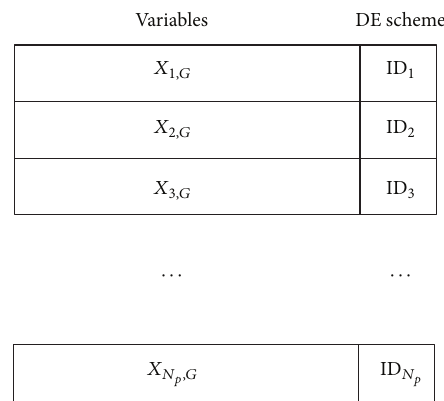
Figure 1: The encoding of individuals in heterogeneous